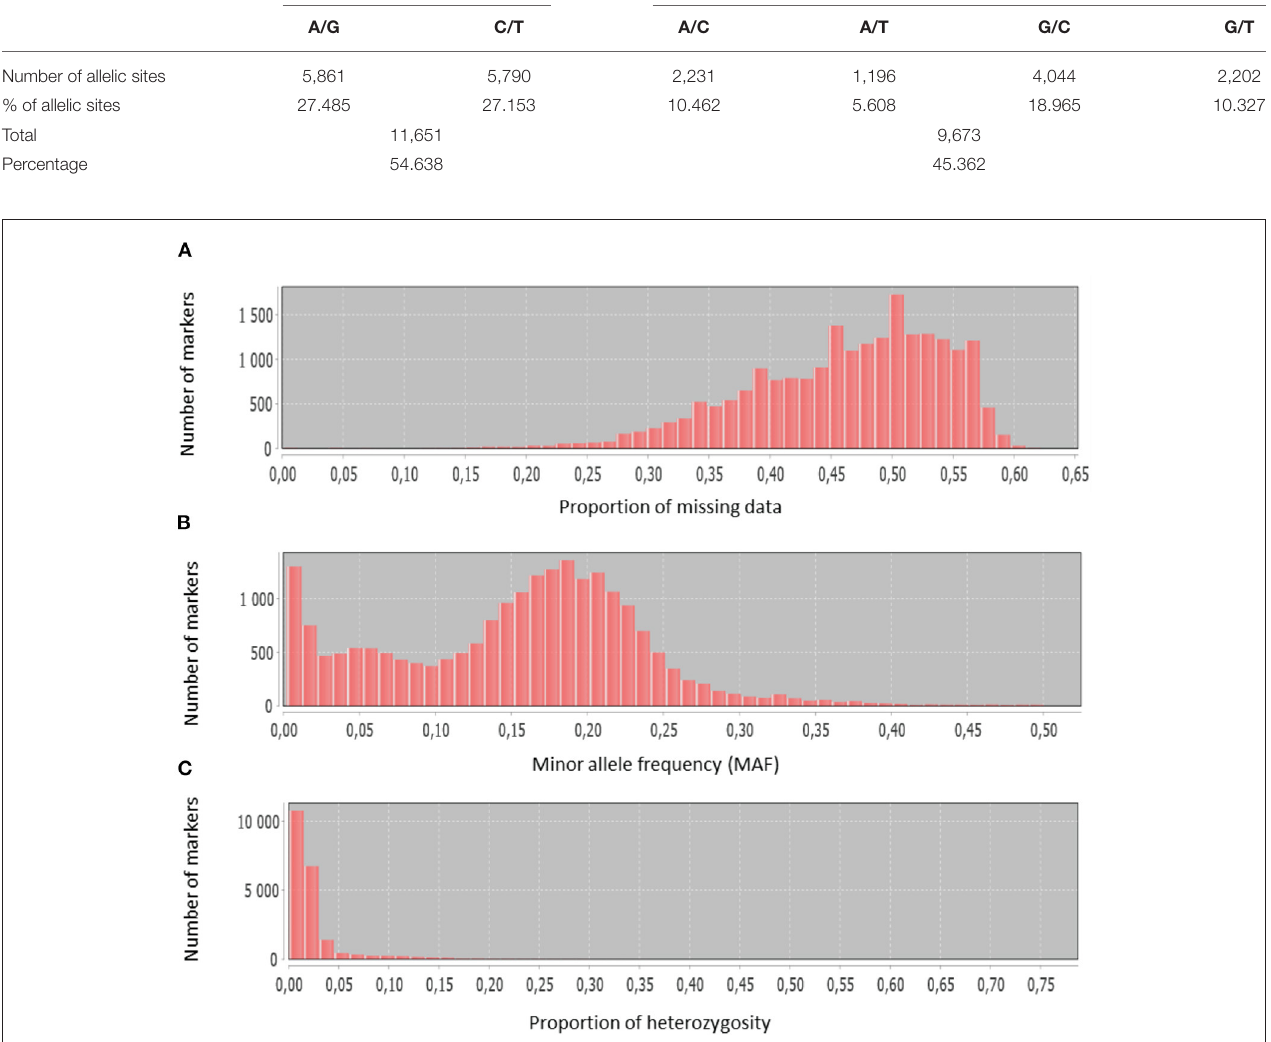
FIGURE 2 | Histograms showing basic SNP characteristics: (A) proportion of missing data, (B) minor allele frequency, (C) proportion of heterozygosity.